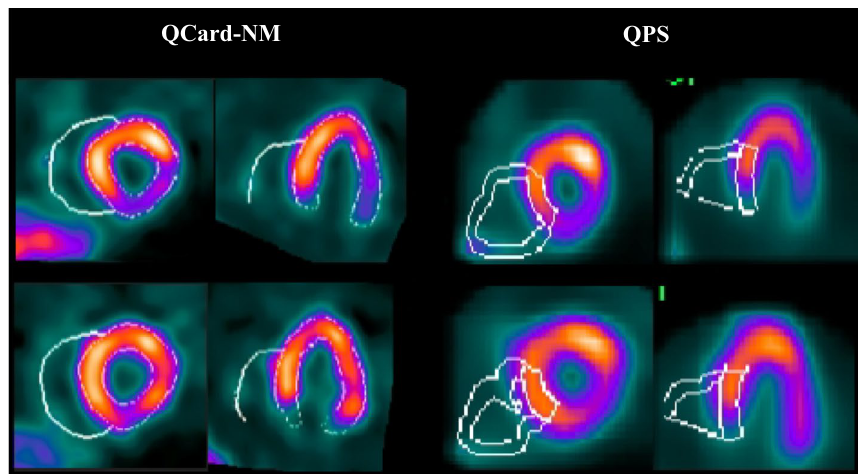
Fig. 7 An example of repeated scans with segmentation results of the QCard-NM and QPS. First and second rows represent the supine and prone scans, respectively;